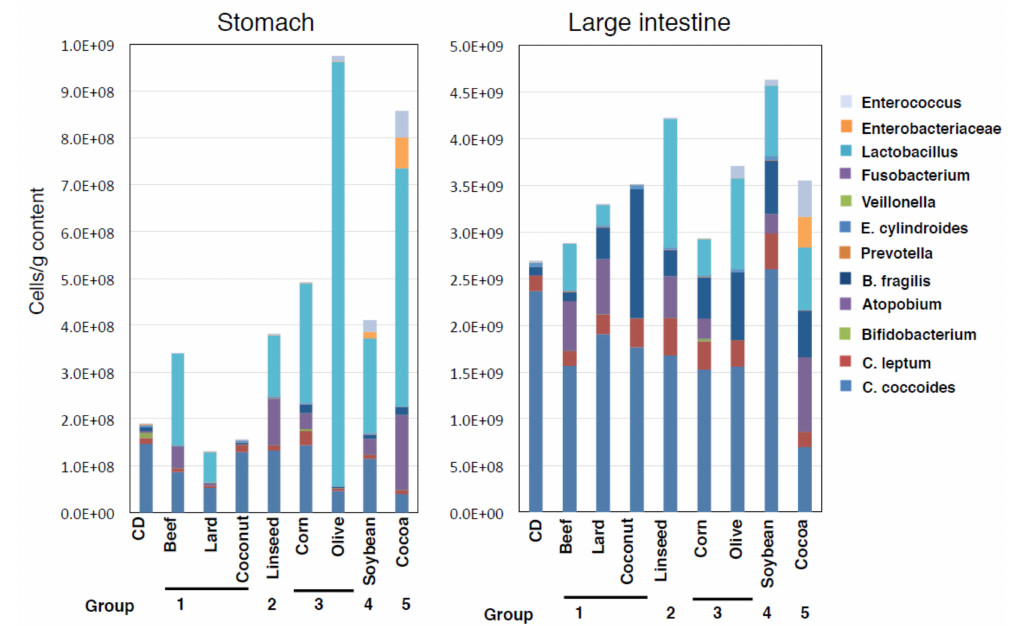
Figure 7. Alterations in microbial abundance in the gastrointestinal tract in various HFD-fed mice. Absolute numbers of the 12 major kinds of gastrointestinal bacteria in the stomach and large intestine, quantified at the group-specific level using qPCR. Data are represented as a stacked bar chart with eight mice per